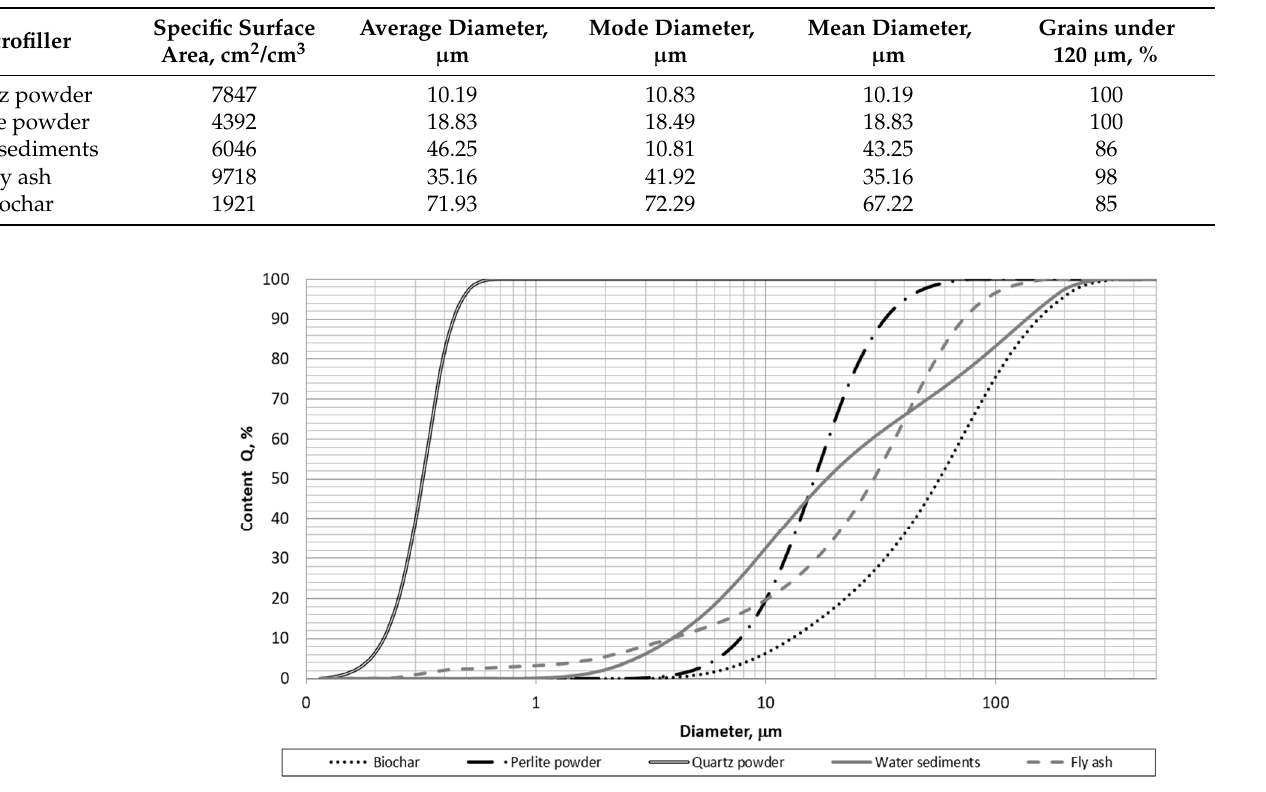
Figure 1. Grain size distribution of biochar—dotted line in comparison with other materials used as polymer concrete microfillers.